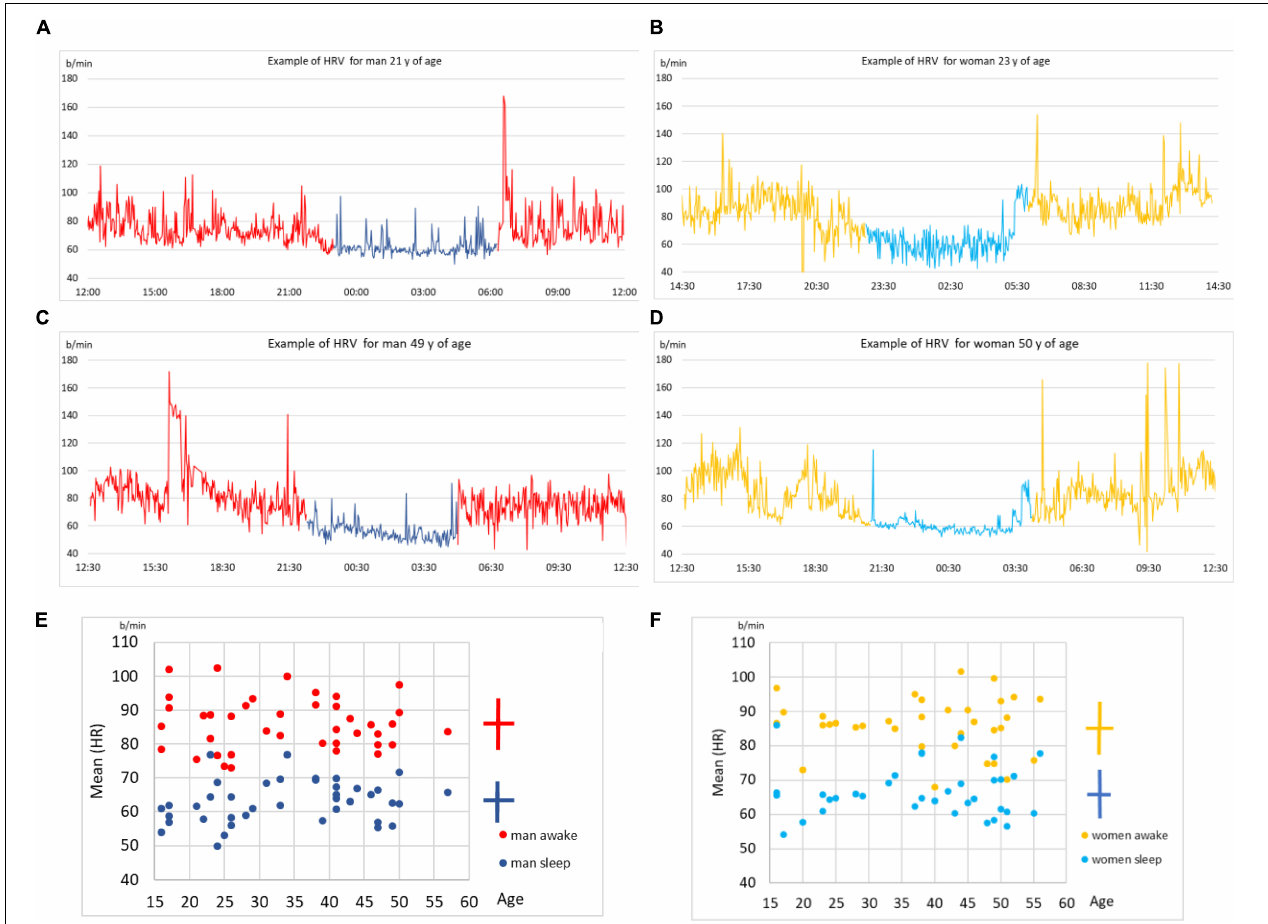
FIGURE 2 | (A) Time series of beat-to-beat HRV data (heart rate as function of time) over a day (24 h) for a male subject, 21 years of age. Part of the day when the subject slept is indicated in blue (self-reported information). (B) The same data but for a female subject, 23 years of age. (C) The same data for another male subject, 49 years of age. (D) The same data for another female subject, 50 years of age. (E) Scatter plot of age (shown on x ) vs. mean heart rate (HR, shown on y ) for all male subjects in our sample. Each male subject is represented as two points, one for sleep mean HR and the other of awake mean HR. Mean value and standard deviation are indicated by the cross symbol next to the scatter plot. (F) The same as in (E) but for all female subjects in our sample.